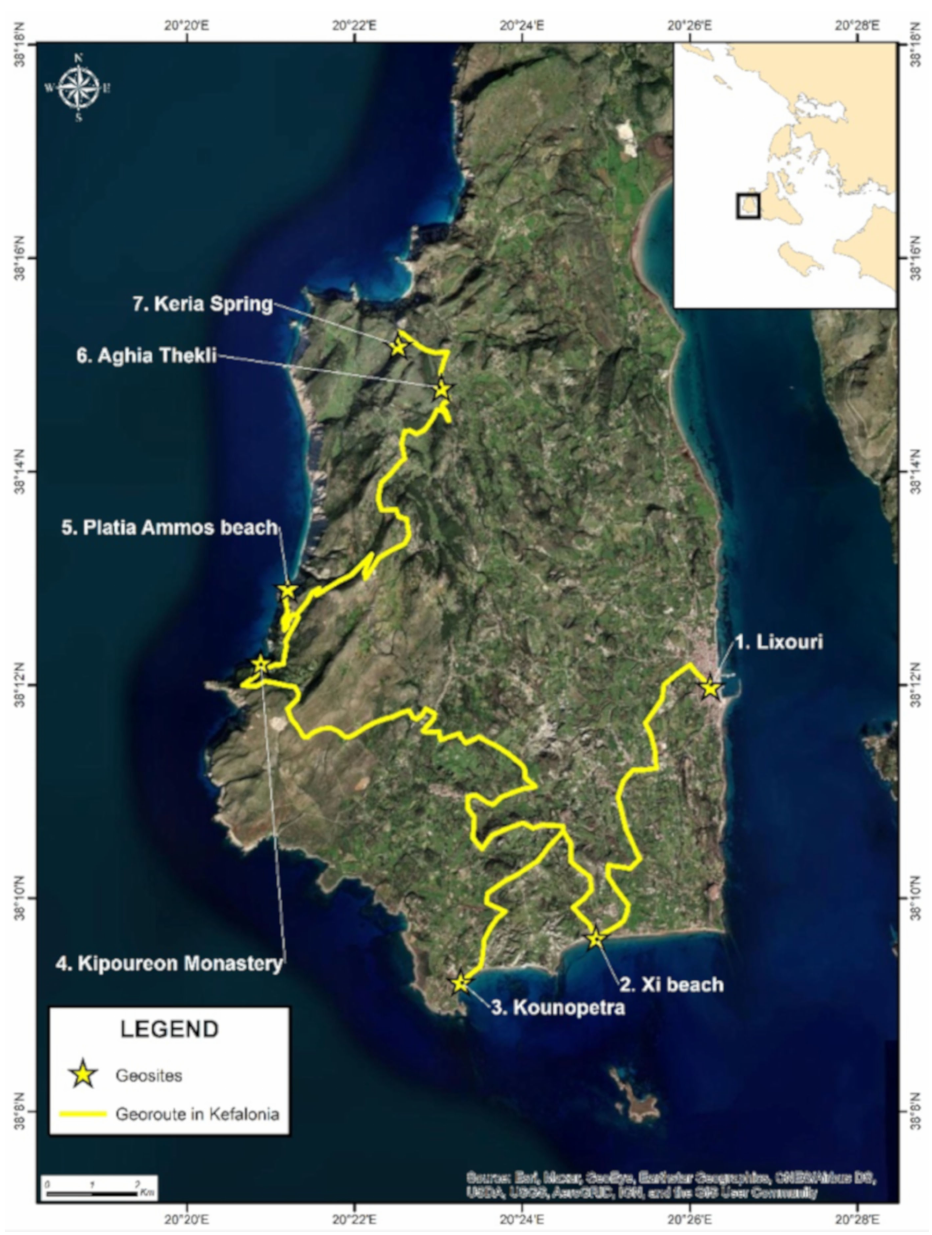
Figure 14. Designed georoute for the Paliki peninsula, Kefalonia